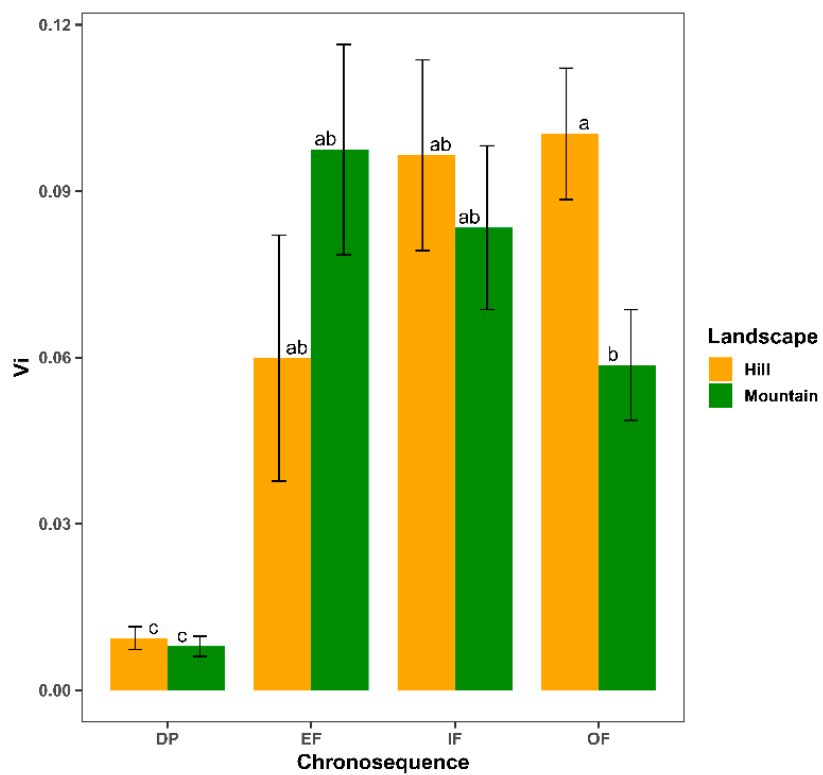
Figure 5. Means ± SE for species-level vulnerability (Vi) for the different successional categories (DP, degraded pasture; EF, early forest; IF, intermediate forest; OF, old-growth forest or mature forest) compared in the two landscape types (hill and mountain). Values between landscapes within each successional category followed by the same letter do not differ statistically according to Fisher’s LSD post hoc test ( p < 0.05).